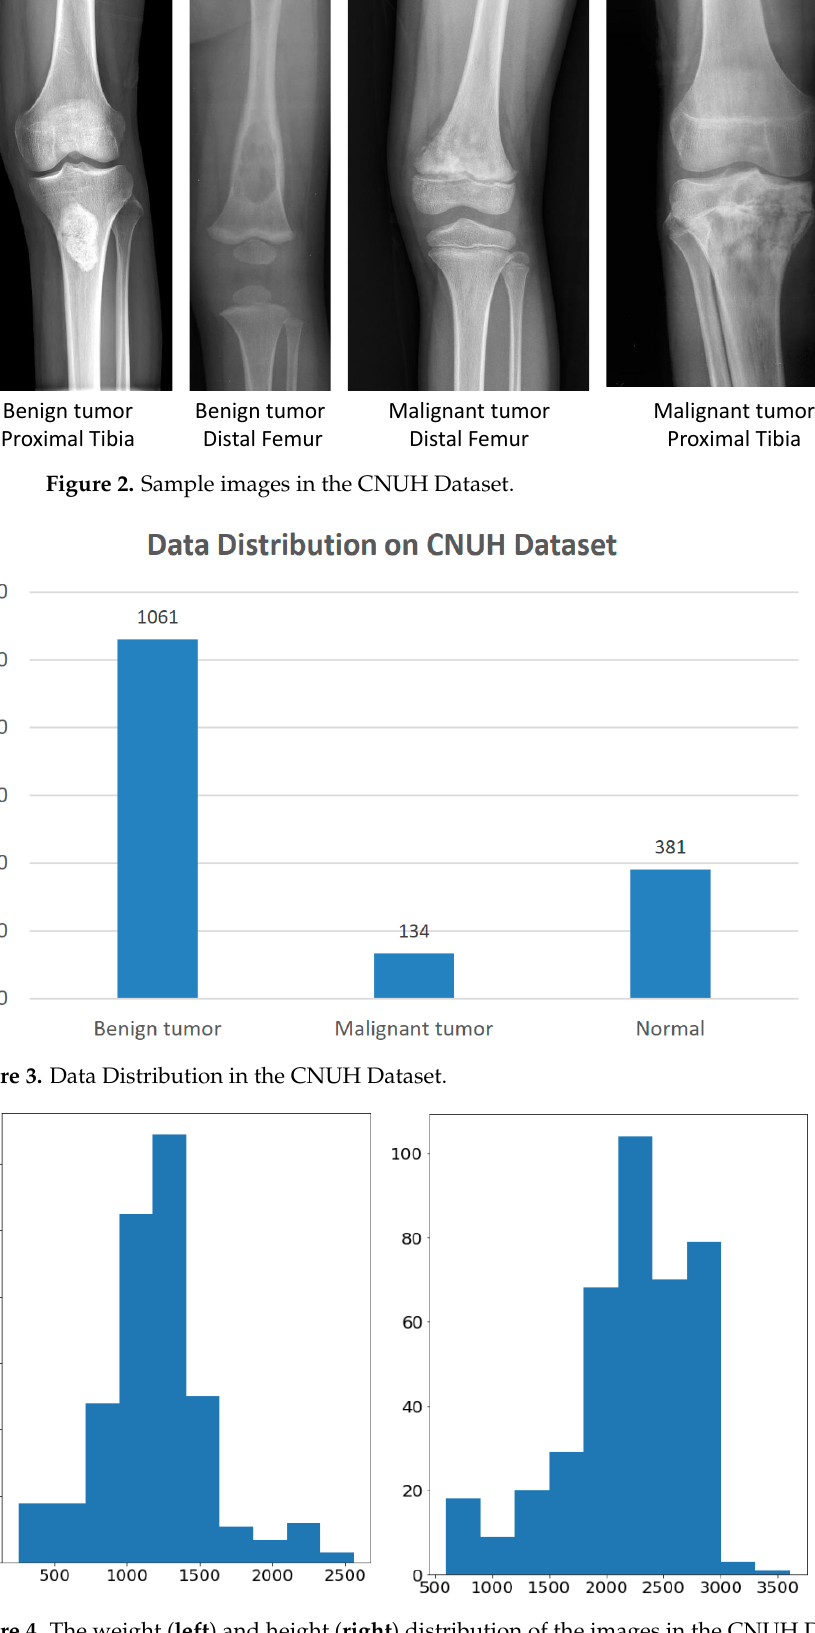
Figure 4. The weight ( left ) and height ( right ) distribution of the images in the CNUH